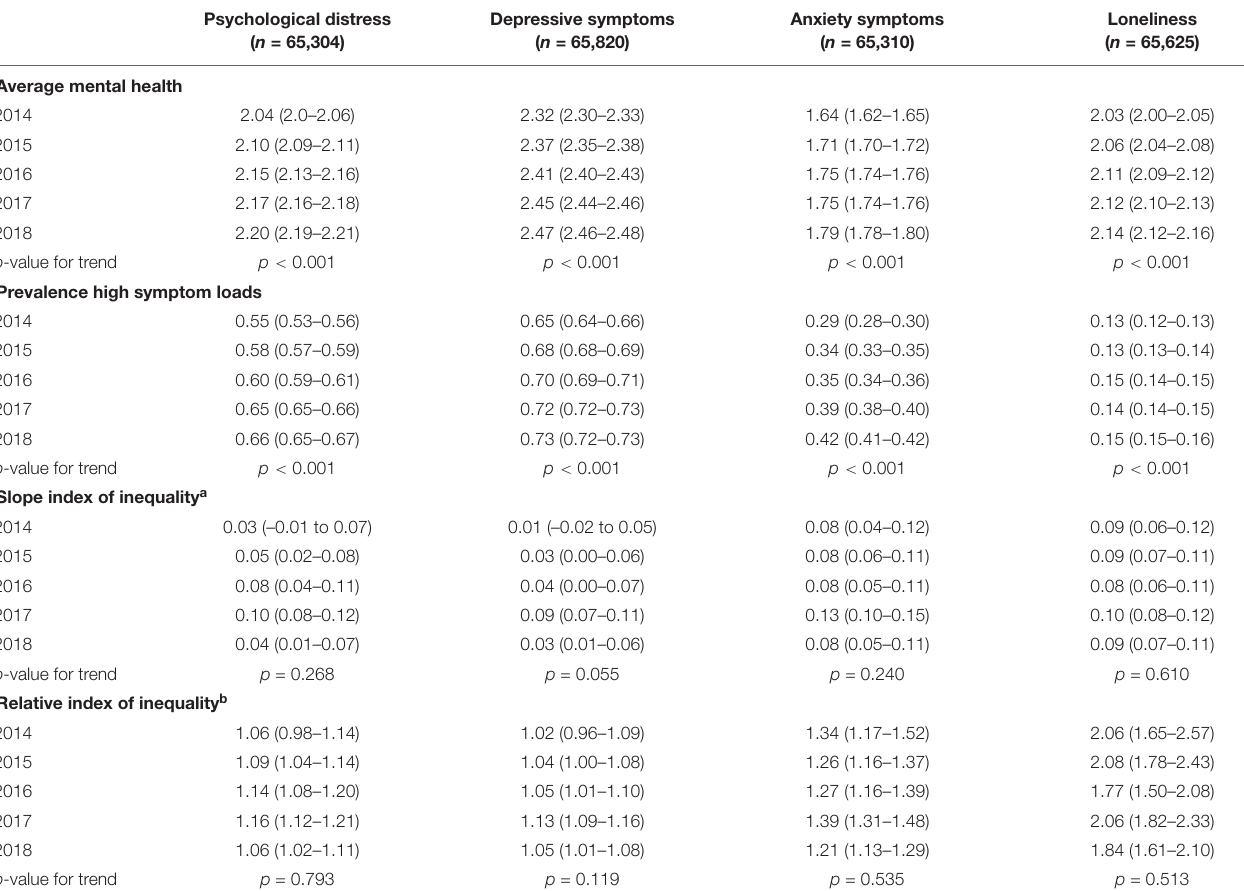
TABLE 2 | Average psychological distress, prevalence’s of high symptom load, absolute and relative inequalities in mental health* among girls between 2014 and 2018 (five cycles) in the Ungdata survey. Psychological distress Depressive symptoms ( n = 65,304) ( n = 65,820)